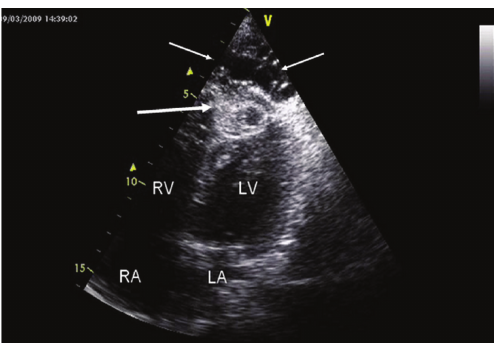
Figure 1: Apical four chamber view, revealing multiple hydatid cysts. Multiple small cysts surrounding and obliterating the apical region (small arrows). Relatively bigger cyst invasing the apicoseptal region (big arrow).